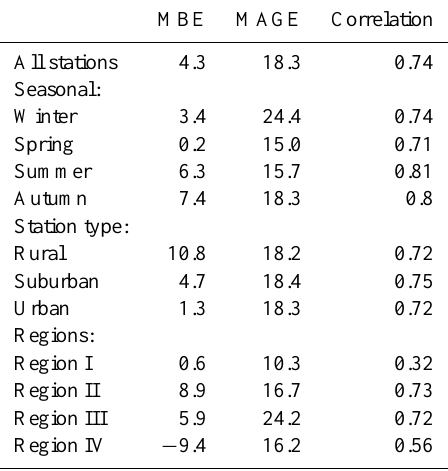
Table 2. Error statistics for GEM-AQ model performance – 24h running average of PM 10 concentrations in µgm − 3 . MBE